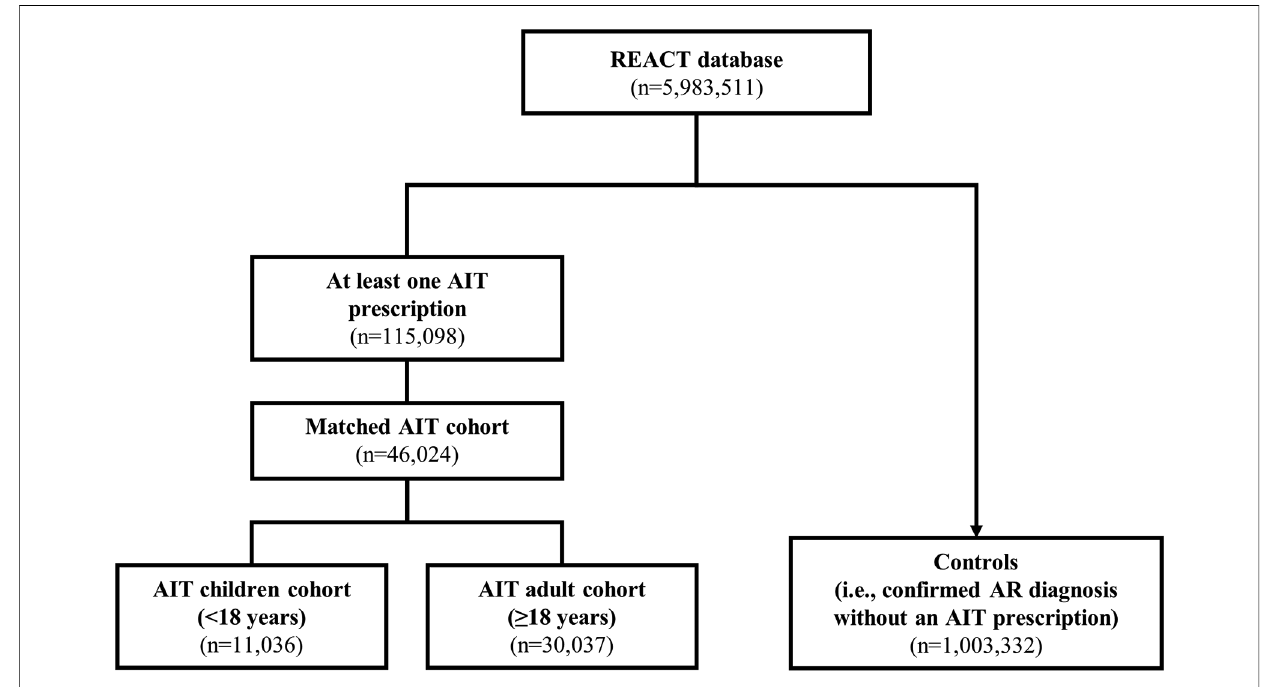
FIGURE 1 Subject selection in the main REACT study (2007 – 2017). Data are adapted from the main publication (47). The AIT age cohorts were formed by re-matching subjects from the main cohort, by age. AIT subjects who could not fi nd a match were excluded from the cohorts. In addition to the children and adults in the AIT group, the entire group of subjects diagnosed with AR and without prescriptions for AIT were included as controls. AIT, allergy immunotherapy; AR, allergic rhinitis; REACT, REAl-world effeCtiveness in allergy